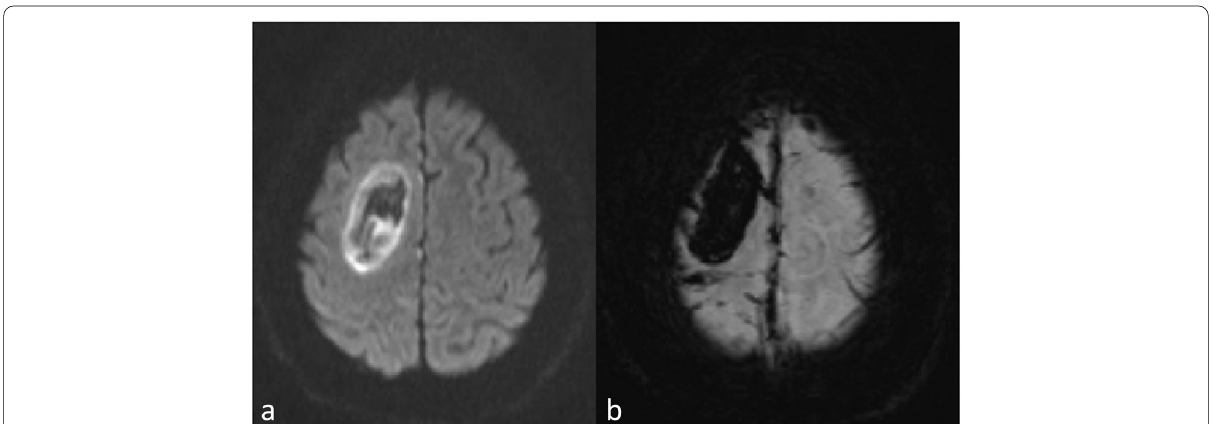
Fig. 1 a Diffusion weighted and b susceptibility weighted MRI sequences. Accute to subaccute hemorrhagic infarction in the right posterior high frontal region probably due to cortical venous thrombosis. A few right posterior frontal cortical veins show blooming adjacent to the hemorrhagic